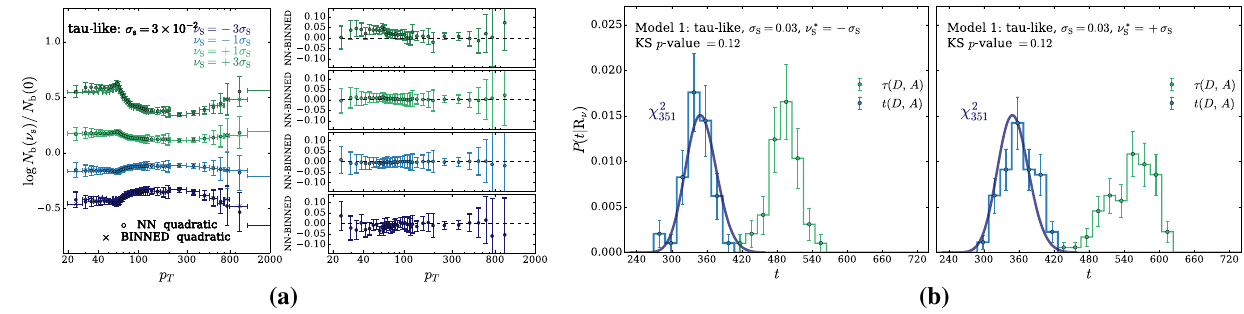
Fig. 22 Same as Fig. 21, but for Model 1 and 600 (cid:16) 000 additional events in the region of high transverse